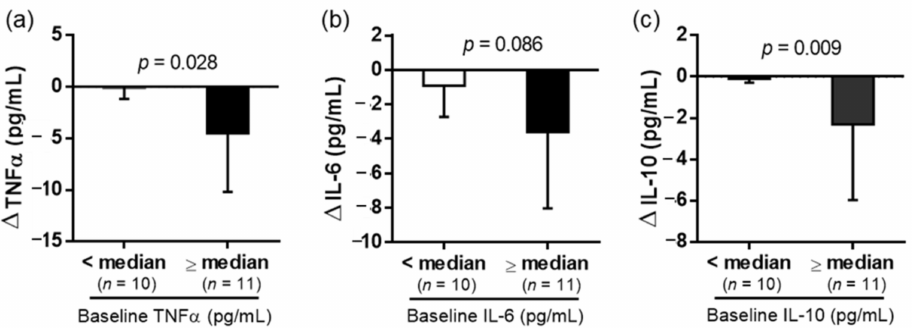
Figure 4. Subgroup analysis according to the baseline ( a ) TNF α , ( b ) IL-6, and ( c ) IL-10 levels (<median, n = 10; ≥ median, n = 11). Values are presented as mean ± SD. Unpaired t -test was used to compare the means of baseline and end-of-the study measurements. Significant differences: p < 0.05. TNF, tumor necrosis factor; and IL,